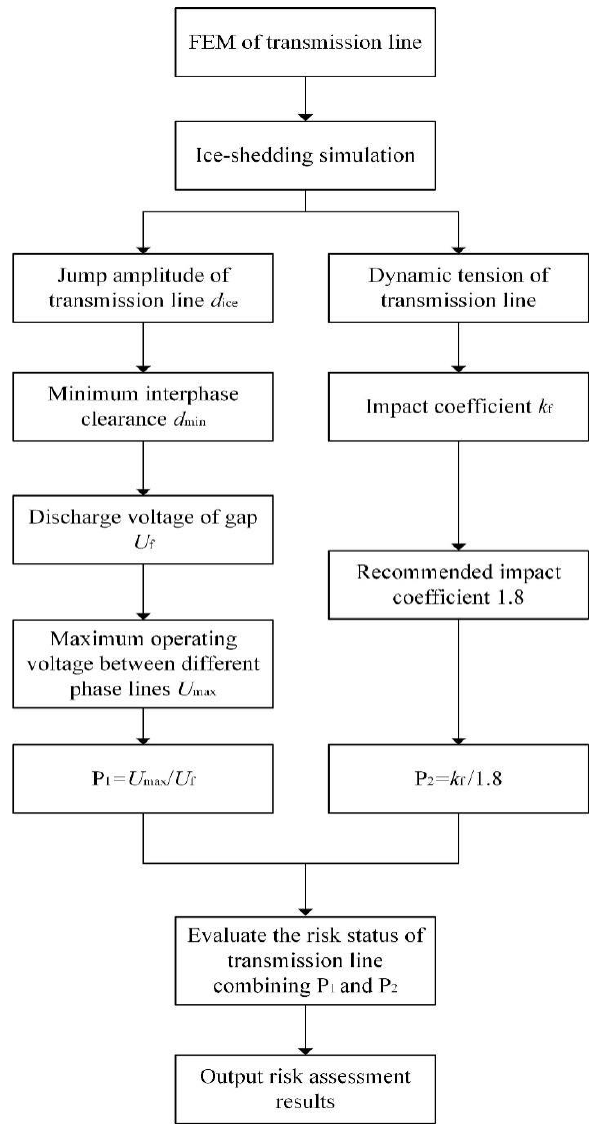
Figure 1. Risk assessment flowchart.